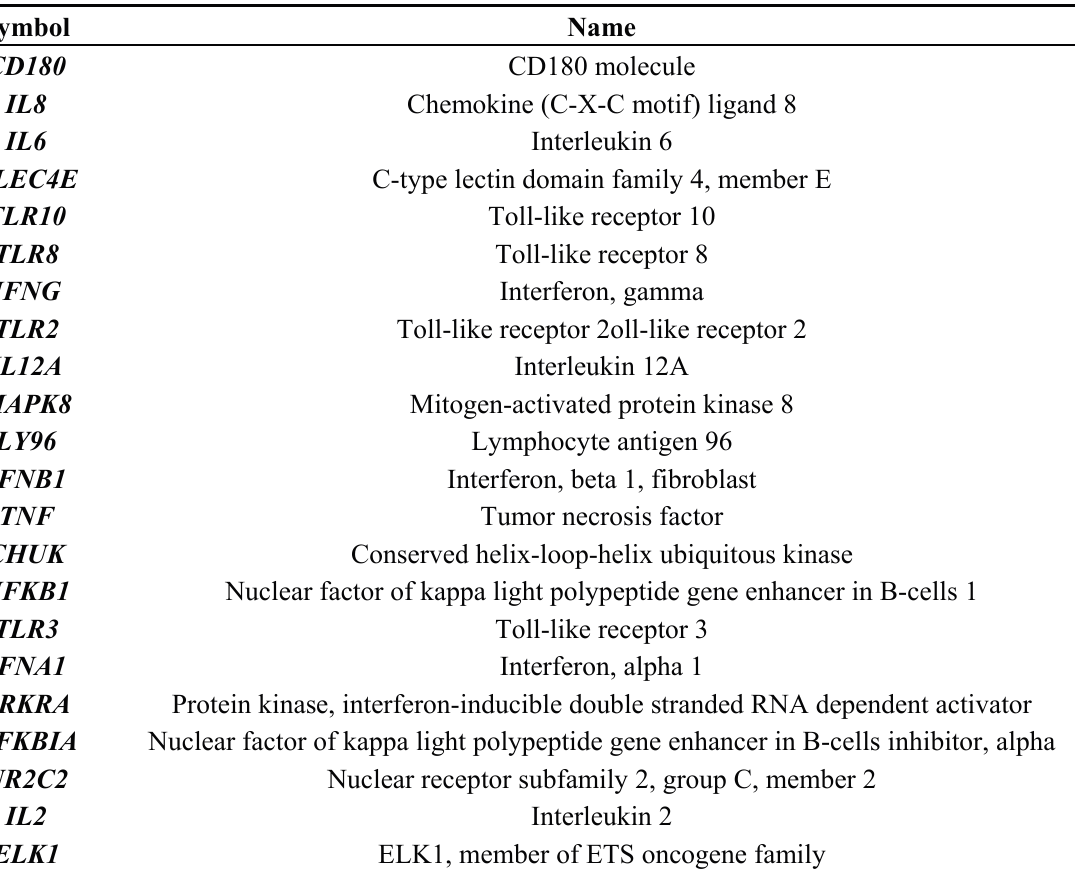
Table 1. Interferon- and cytokine-related genes upregulated by at least 50-fold in HepG2-HBV core cells analyzed using real-time